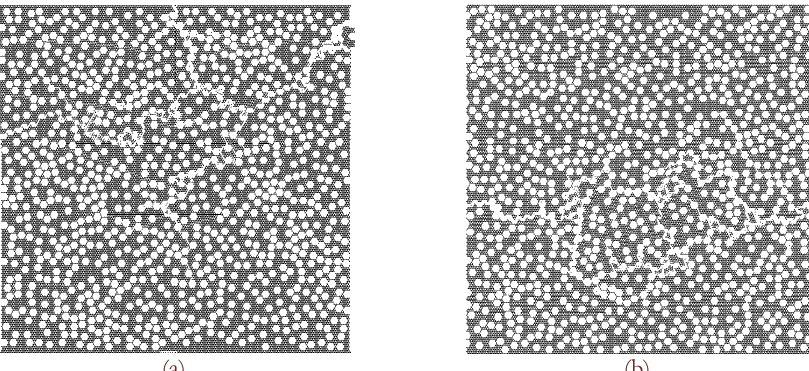
Figure 5: Fracture patterns of the model specimen with the porosity of 28 % at the moment of the first macrocrack propagation under uniaxial compression (a) and shear loading